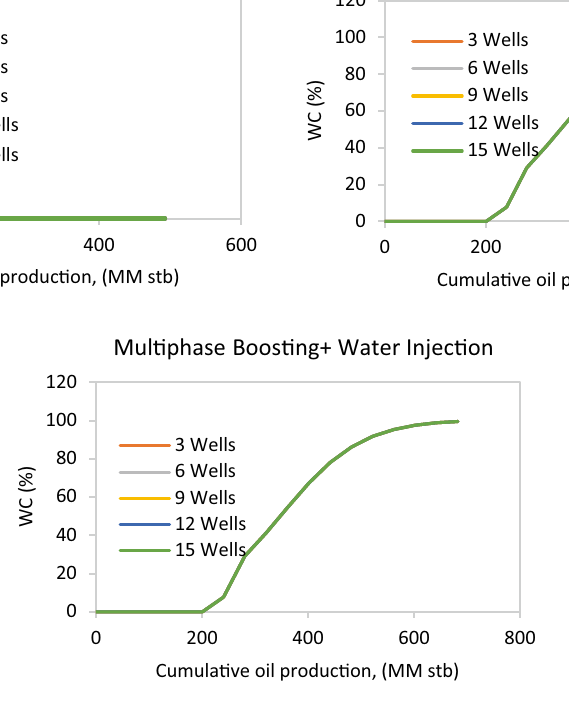
Fig. 16 Potential water cut for all recovery scenarios